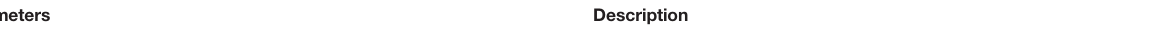
TABLE 1 | Drug exposure related